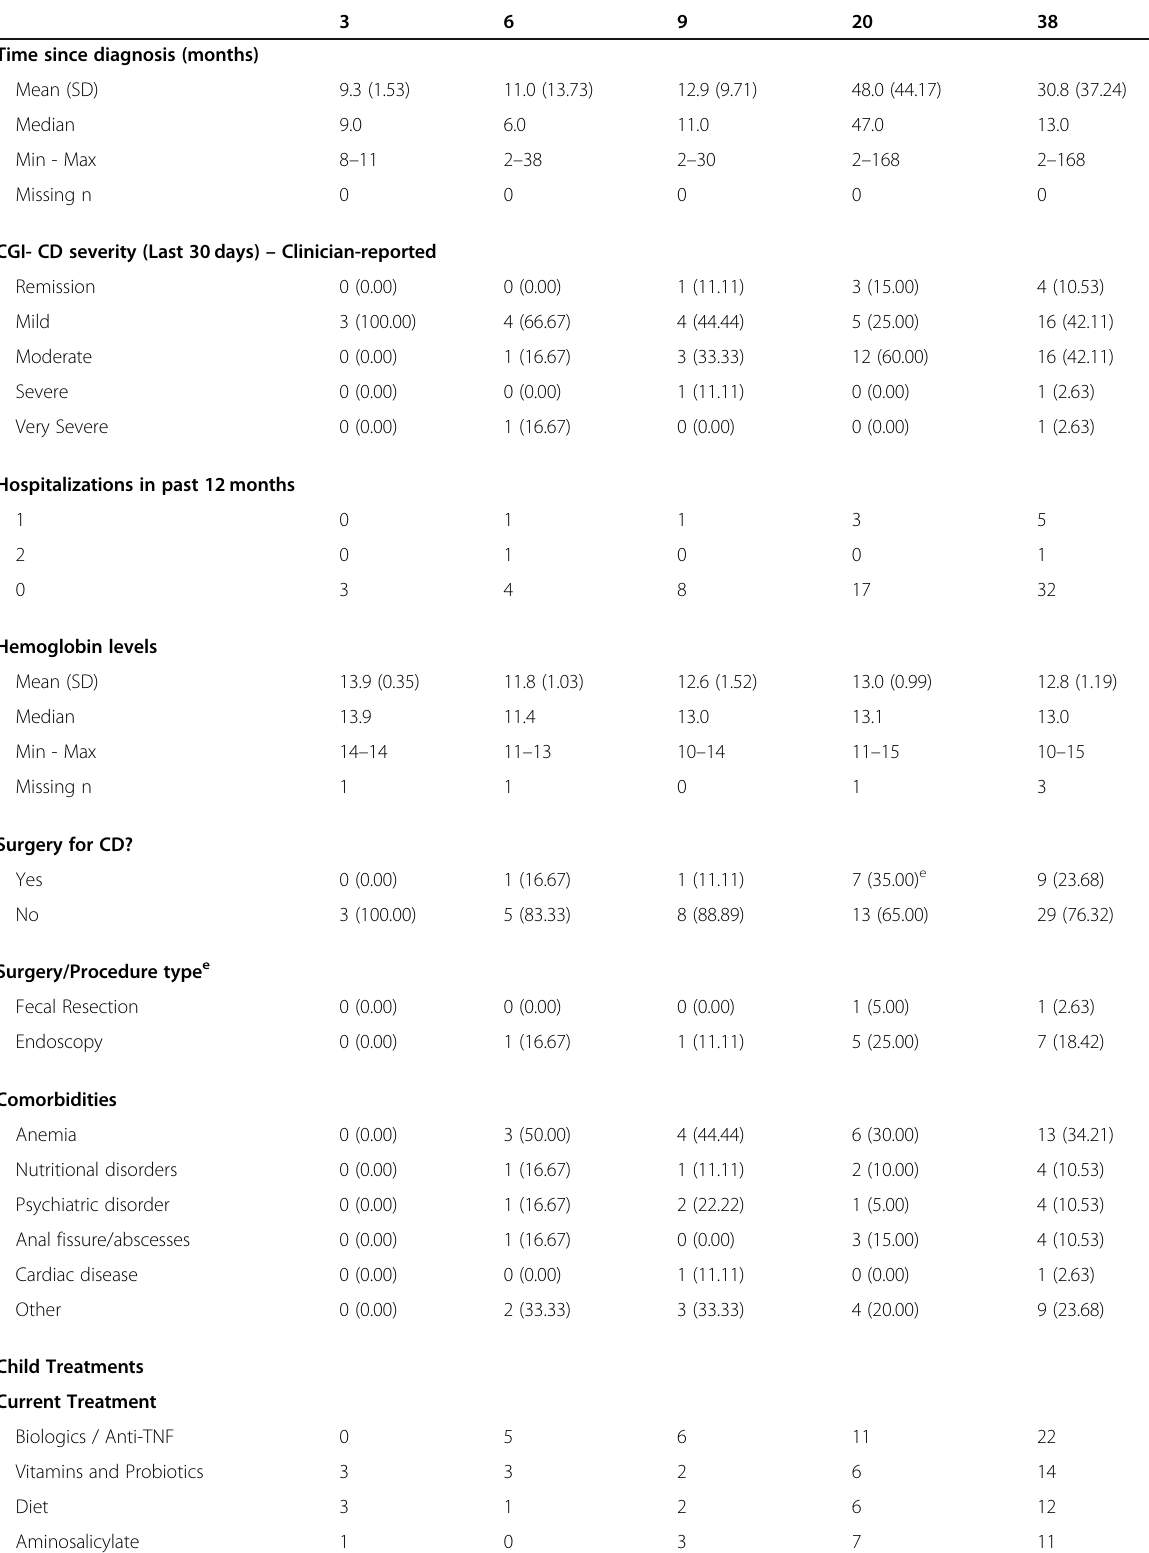
Table 2 Clinical Characteristics of Children with